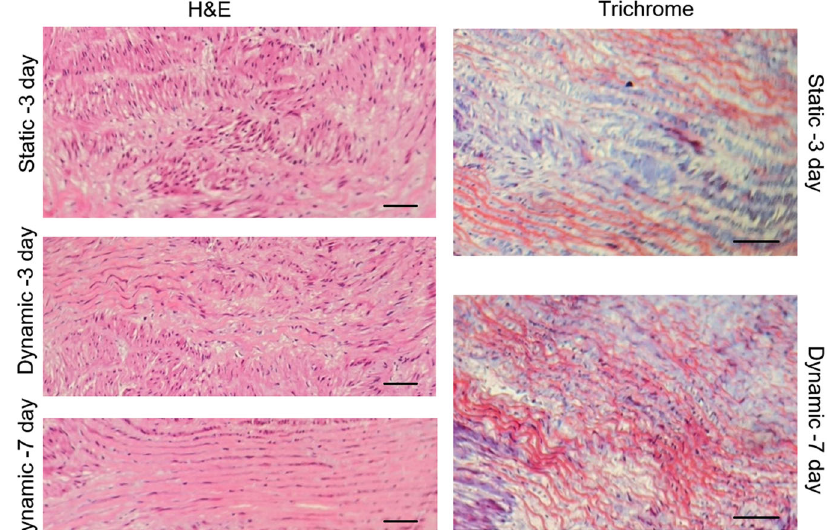
Fig. 2 A Cell viability of SMC seeded on the acellular scaffold without (S) and with (SR) the rewashing step, and the acellular scaffold froze at − 20 °C (SF) at 24, 48 and 72 h. MTT assay was utilized to evaluate cytotoxicity of the scaffold. The obtained data reveals in the S viability reduces signi fi cantly in each three-time points especially 48 and 72 h. However, in SR and SF viability reduction is much less than S. B Swelling ratio test. The native and BS samples were weighed in